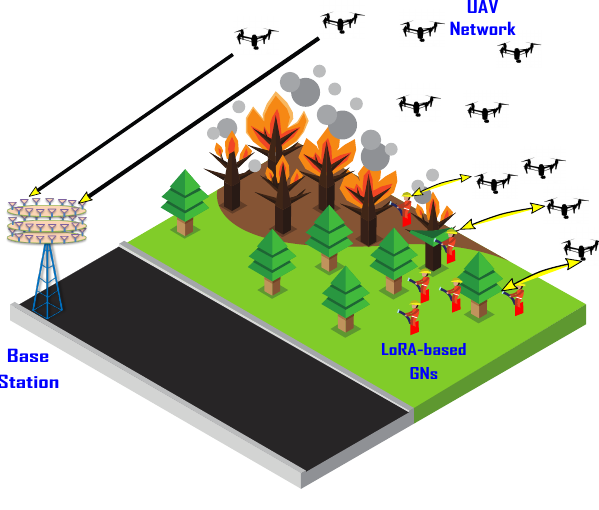
Figure 1. Illustration of UAV-enabled LoRa architecture in the backdrop of a